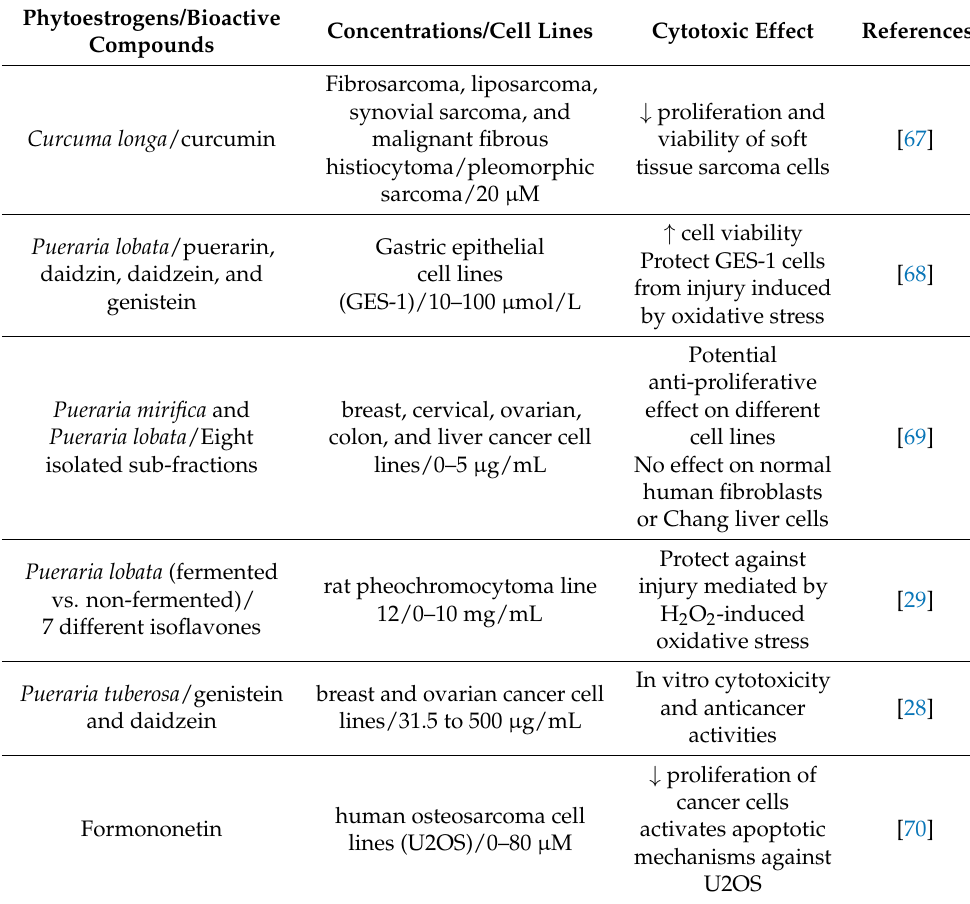
Table 7. In vitro cytotoxic activities of some phytoestrogenic sources and their effect on different cancer cell